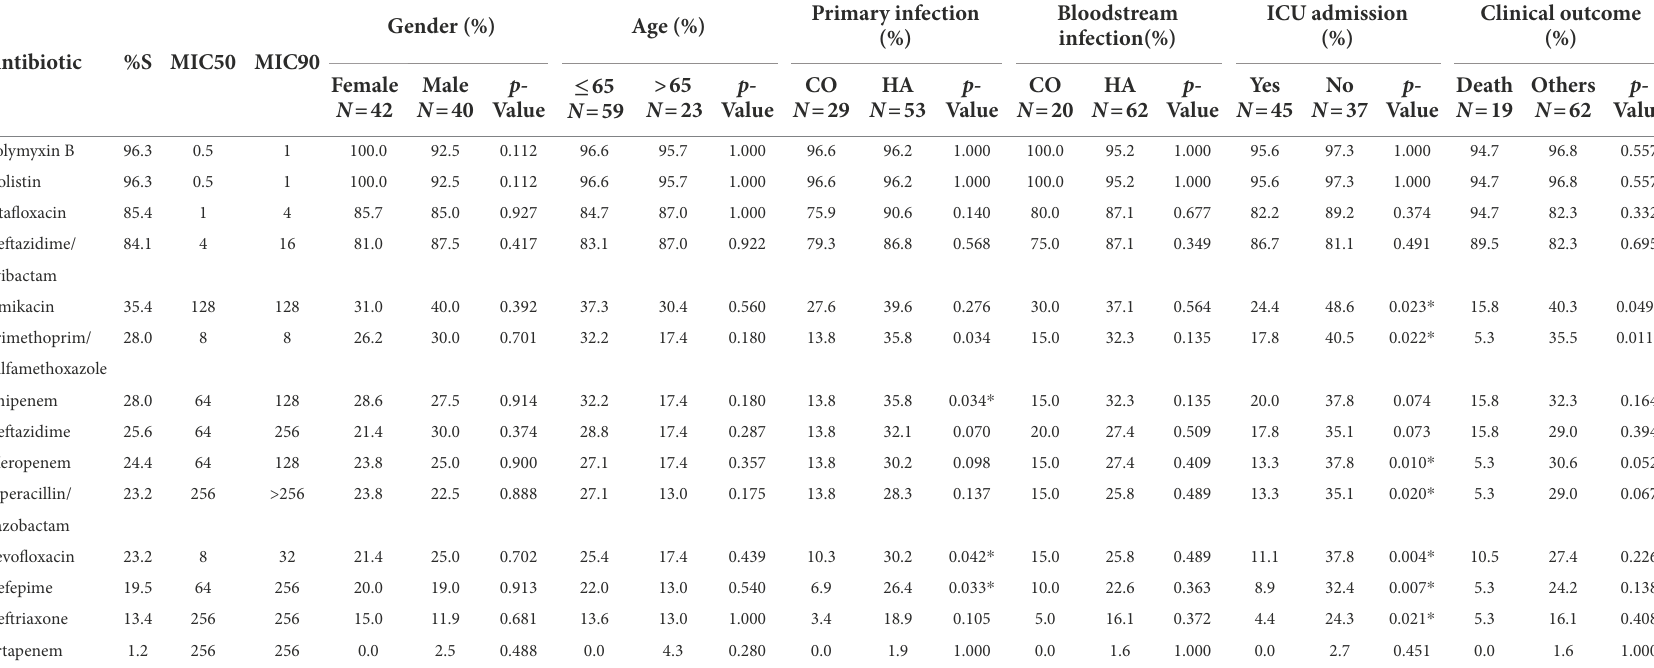
TABLE 4 Comparison of the antimicrobial susceptibility rates of A. baumannii isolates in clinical features.